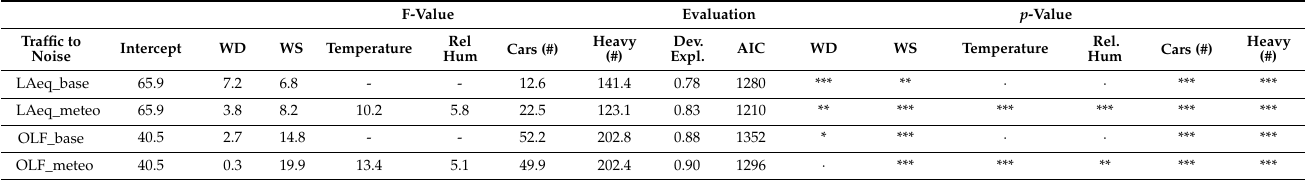
Table 1. Summary of the GAM models for the noise parameters: L Aeq and OLF, with and without temperature and relative humidity. F-Value Evaluation p